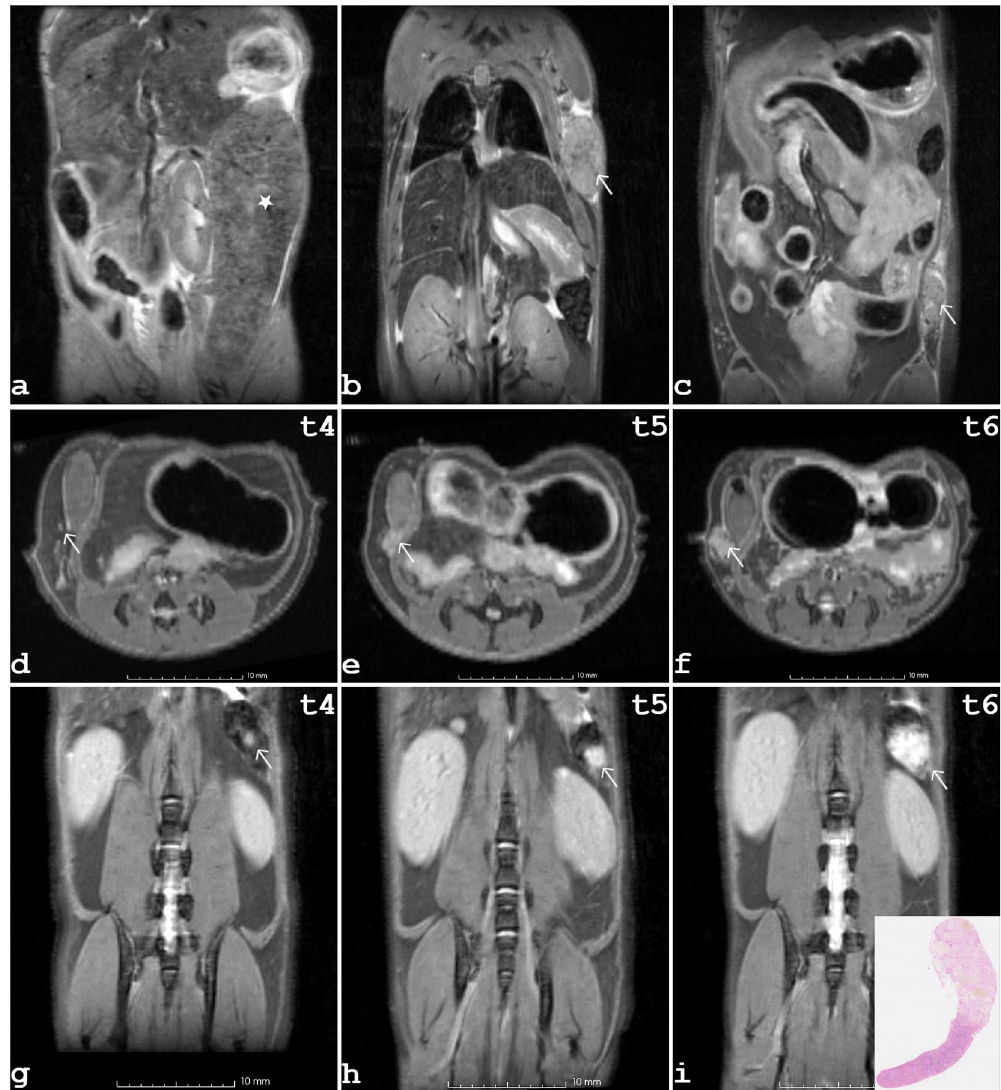
Figure 4. Representative tumor findings in mutant mice. At the third observation time point, a female mutant was found to have a large spleen ( a ). In ( b ) tumorous tissue was observed in the axillary region of an 8-month- old female. In ( c ) cancerous tissue is located in the pelvic region of a one-year-old female. ( d – i ) panel showing 2D fs-RARE data, starting at eight months of age, tracking cancer development in two mutant individuals over a six-month period. A mammary tumor is shown in ( d–f ), and a splenic hemangioma (tumor indicated by white arrow) is shown in ( g–i ) with the corresponding histologic finding as an insert in ( i